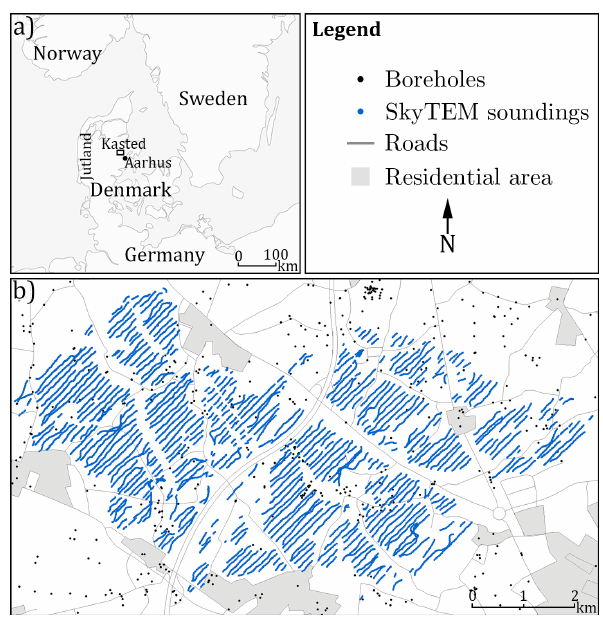
Figure 1. An overview map of the Kasted survey area. (a) shows the geographic location of the survey area, which is marked as a black box; and (b) shows a close-up view of the Kasted survey area with the related datasets and infrastructure